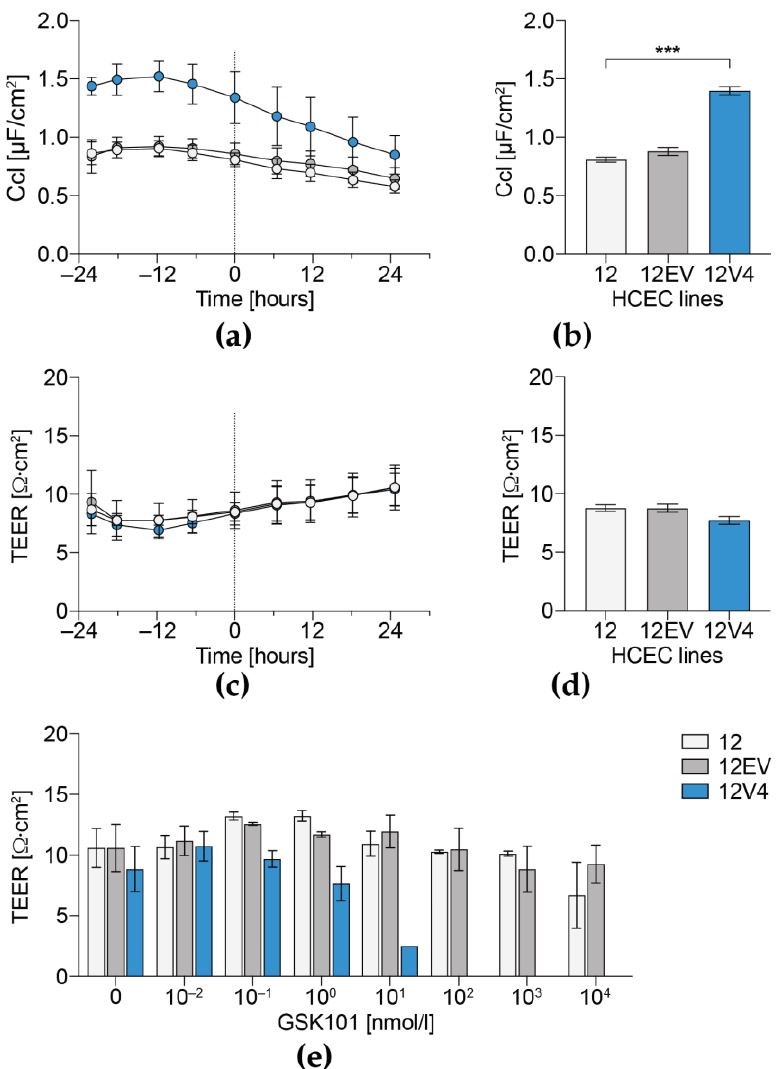
Figure 6. Dependence of GSK101-induced declines in transepithelial electrical resistance (TEER) and cellular capacitance (Ccl) on TRPV4 expression levels. Ccl ( a , b ) and TEER ( c , d ) were measured in unstimulated and stimulated cell populations for up to 48 h. Development of Ccl ( a ) and TEER ( c ) of the untreated control cells over time and comparison of stabilized TEER ( b ) and Ccl ( d ) values of all cells before stimulation and at time point 0 h (from ( a , c )). The data are expressed as means ± SEM of n = 3 from 3 independent experiments. Development of TEER values after 24 h of stimulation with GSK101 ( e ). The data correspond to the means ± SEM of at least n = 6 from three independent experiments. The statistical analyses were carried out using one-way ANOVA followed by Tukey´s multiple comparisons test with *** p < 0.001.